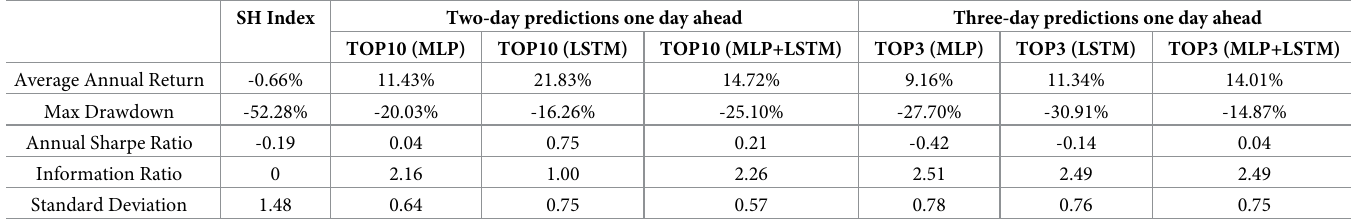
Table 6. One day ahead performance of MLP and LSTM.